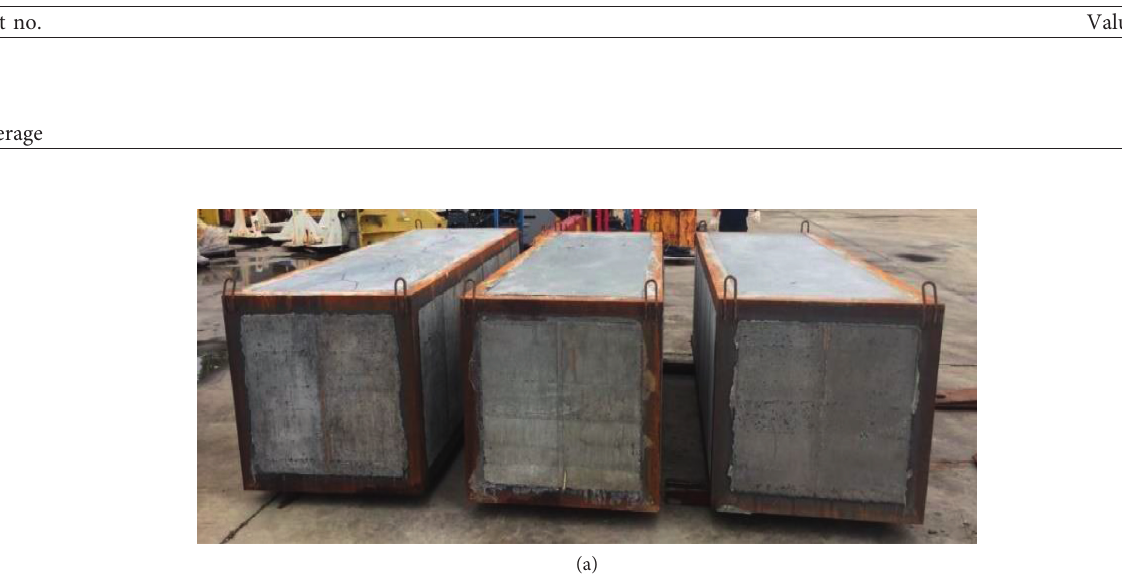
Figure 14: Uniaxial compression testing of a concrete specimen: (a) test setup and (b) test result. Table 5: Uniaxial compressive strength of concrete